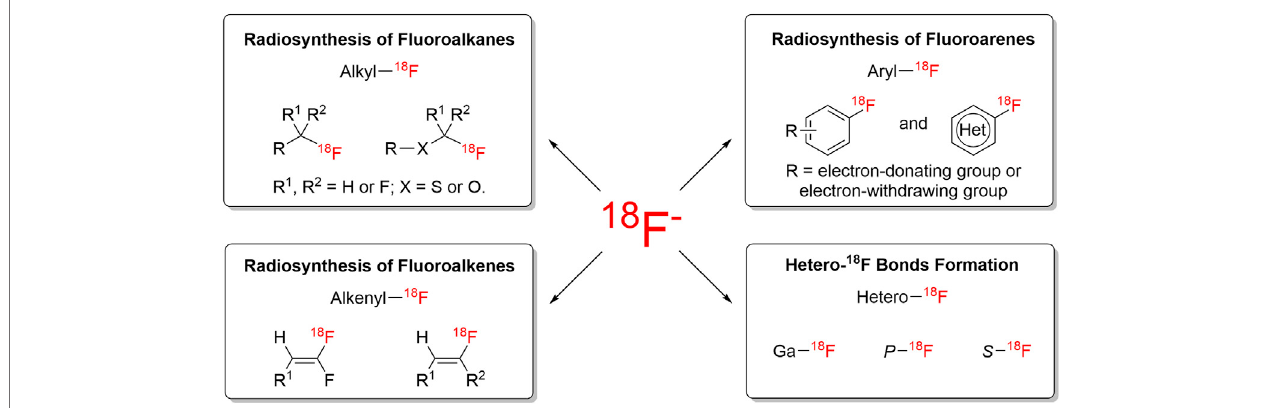
FIGURE 1 | Overview of 18